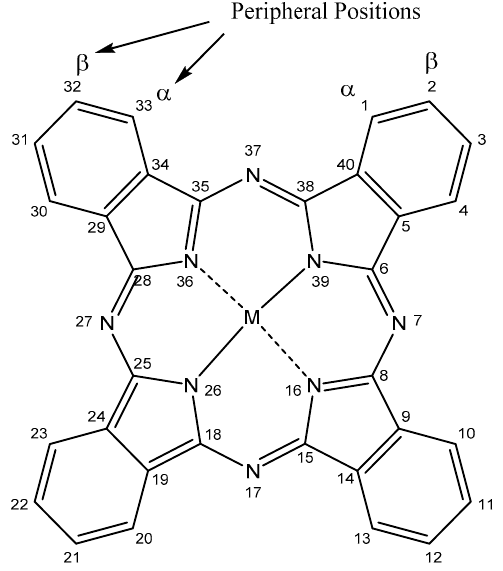
Figure 1. Common ( α and β ) vs. IUPAC systems for labeling metal (M) phthalocyanines.